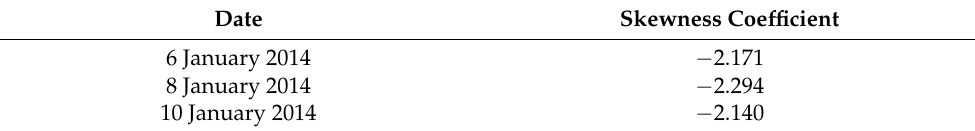
Table 3. Skewness analysis.